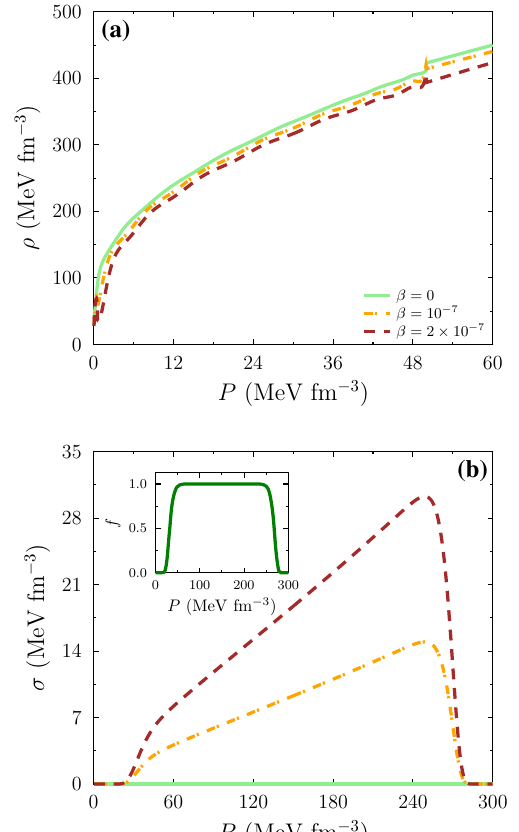
Fig. 4 The mass–radius relation when β value is varied. The data shape, which are NICER data of PSR J0030+0451 ( M ∼ 1 . 4 M (cid:4) ) [65,66] and PSR J0740+6620 ( M ∼ 2 . 1 M (cid:4) ) [67,68], are taken from Ref.